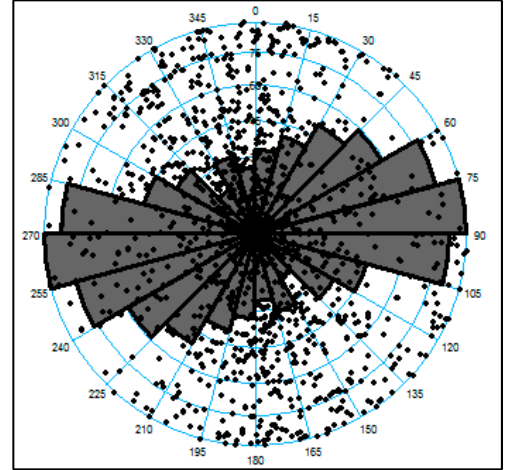
Figure 8. Rose diagram showing the distribution of the azimuth of the extracted fractures from seismic activity.